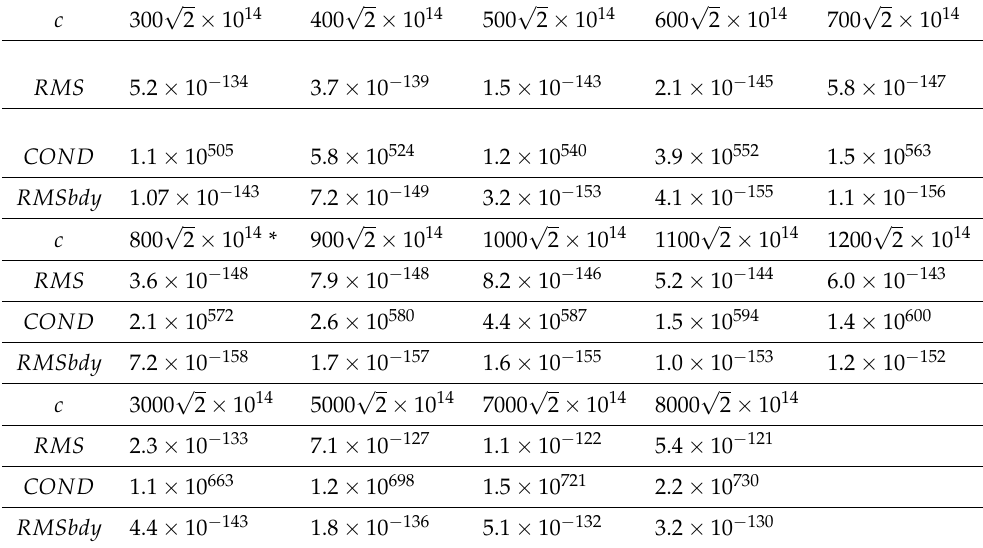
√ 2 × 10 16 , N d = 1681, N t =